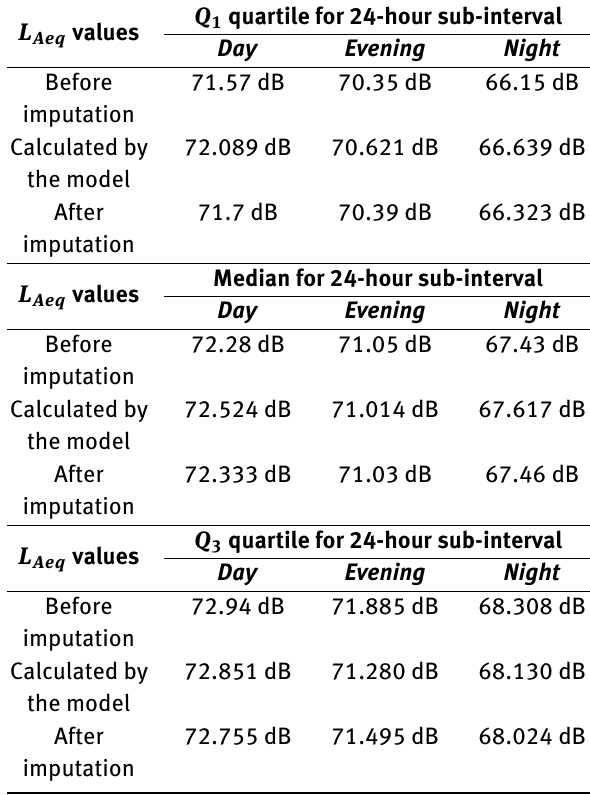
for location no. 2 Table 5: Accuracy of the model with scaling functions at location Aeq